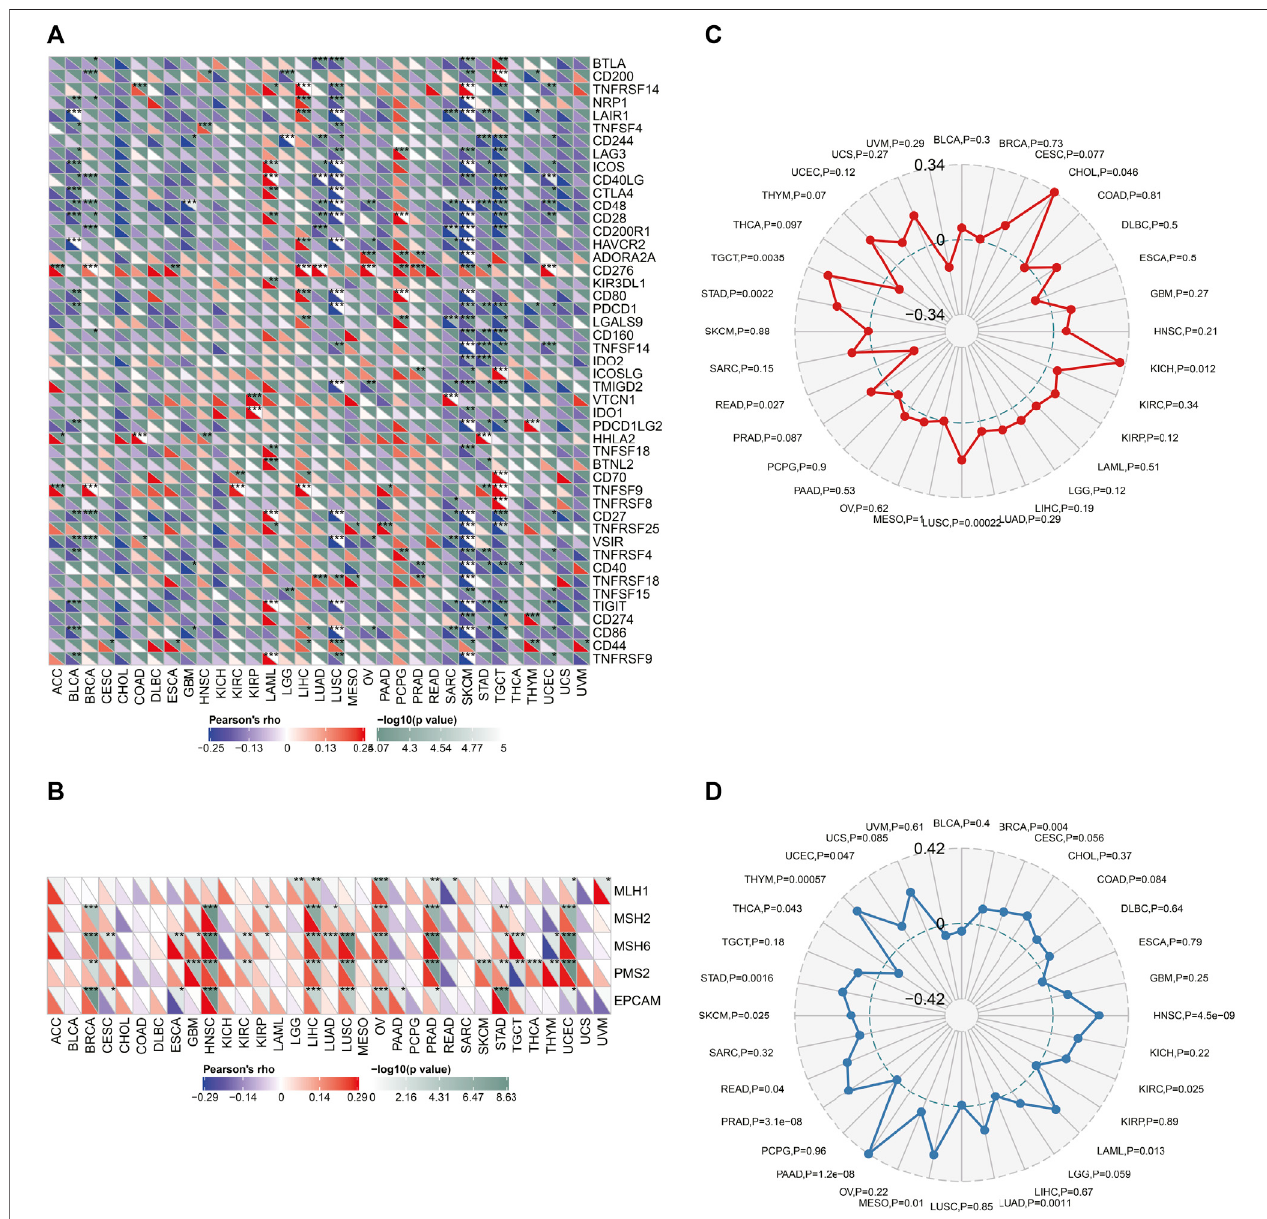
FIGURE 10 | Relationship between SLC6A8 and response to immunotherapy. (A) Correlations between expression of SLC6A8 and representative immune checkpoint genes in different cancers. (B) Correlations of SLC6A8 and 5 component genes of MMR system across cancers. (C) and (D) Correlations of SLC6A8 with MSI (C) and TMB (D) . * p < 0.05, ** p < 0.01, *** p <